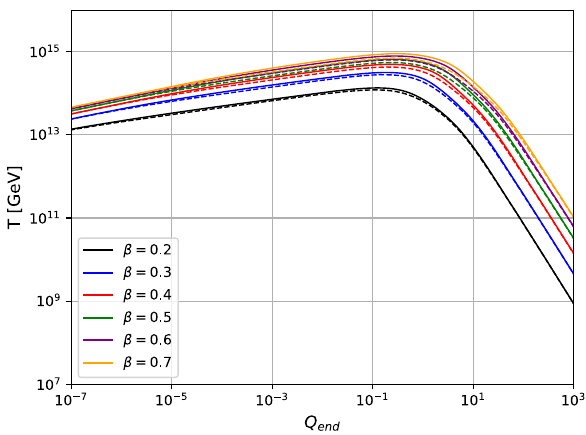
Fig. 3 On the left panel, we plot the temperature of the thermal bath in GeV as a function of Q end , for the same values of β as in Fig. 1. On the right panel, we have the Q (cid:10) − Q end plane, indicating inflation in the weak regime (grey region), strong regime (yellow region), and a